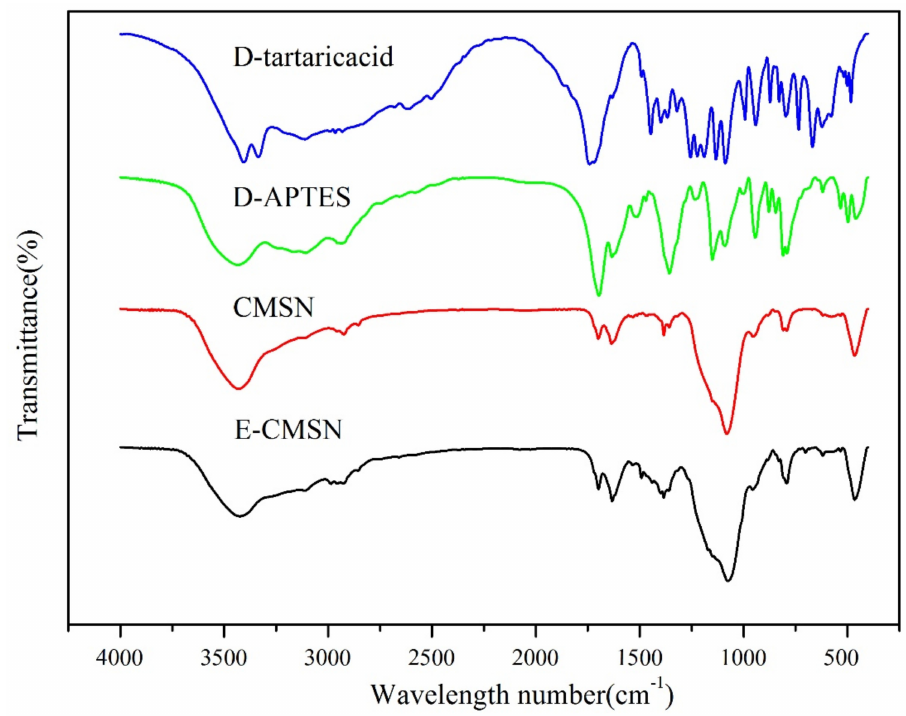
Figure 1. FTIR spectra of D-tartaric acid, D-APTES, chiral mesoporous silica nanoparticles (CMSN) and enlarged chiral mesoporous silica nanoparticles (E-CMSN) from 400 to 4000 cm − 1